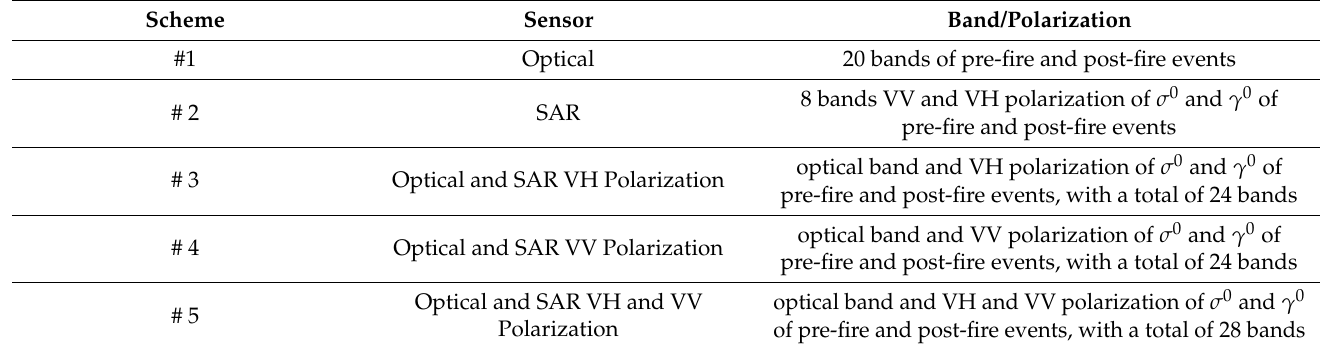
Table 2. Input bands and polarizations for each classification